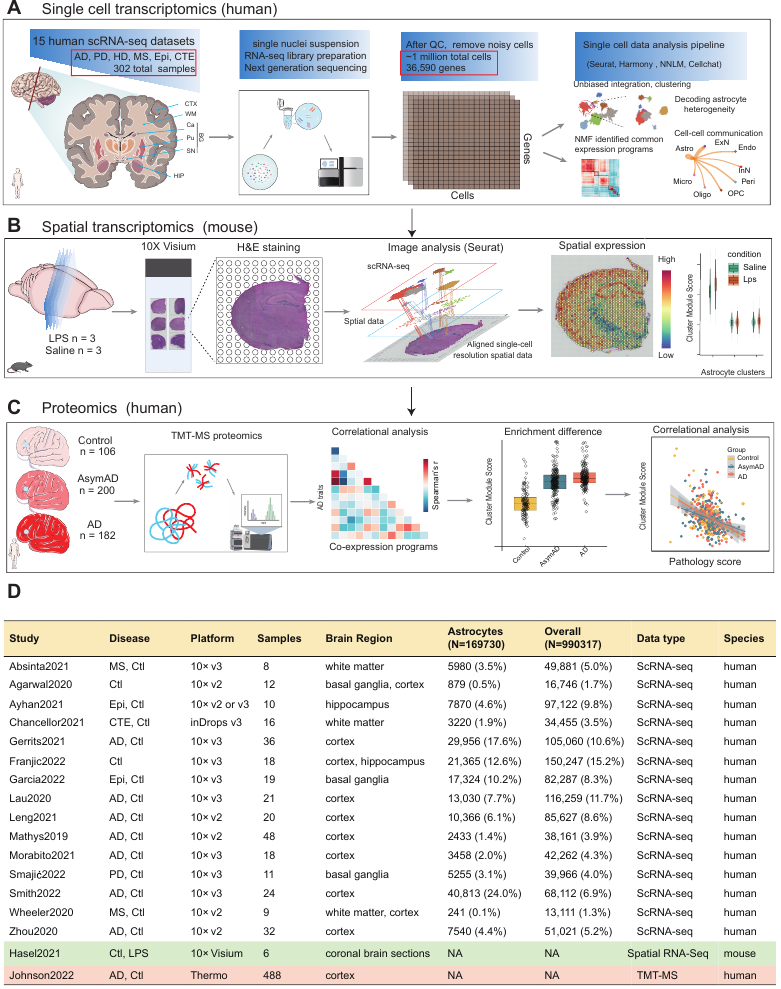
Figure 1. Overview outline of astrocyte dataset categories and analysis pipeline. ( A ) Workflow of data generation, integration, and annotation for the human brains’ single-cell transcriptome datasets. ( B ) Spatial transcriptomics profiling workflow of mouse brains. ( C ) Processing workflow of the TMT- MS proteomics dataset on control, asymptomatic AD (AsymAD), and AD brain tissues. ( D ) Metadata table for all datasets included in this study. Abbreviations: AD, Alzheimer’s disease; PD, Parkinson’s disease; HD, Huntington’s disease; MS, multiple sclerosis; Epi, epilepsy; CTE, chronic traumatic encephalopathy; AsymAD, asymptomatic AD; scRNA-seq, single-cell RNA-sequencing; spatial RNA-seq, spatial RNA-sequencing; TMT-MS, tag mass tag